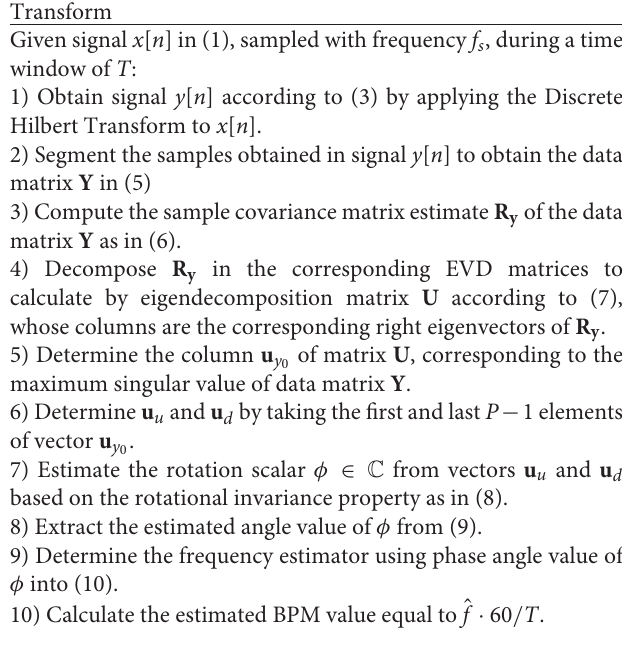
Algorithm 1 : Proposed ESPRIT-based HR estimation via Hilbert